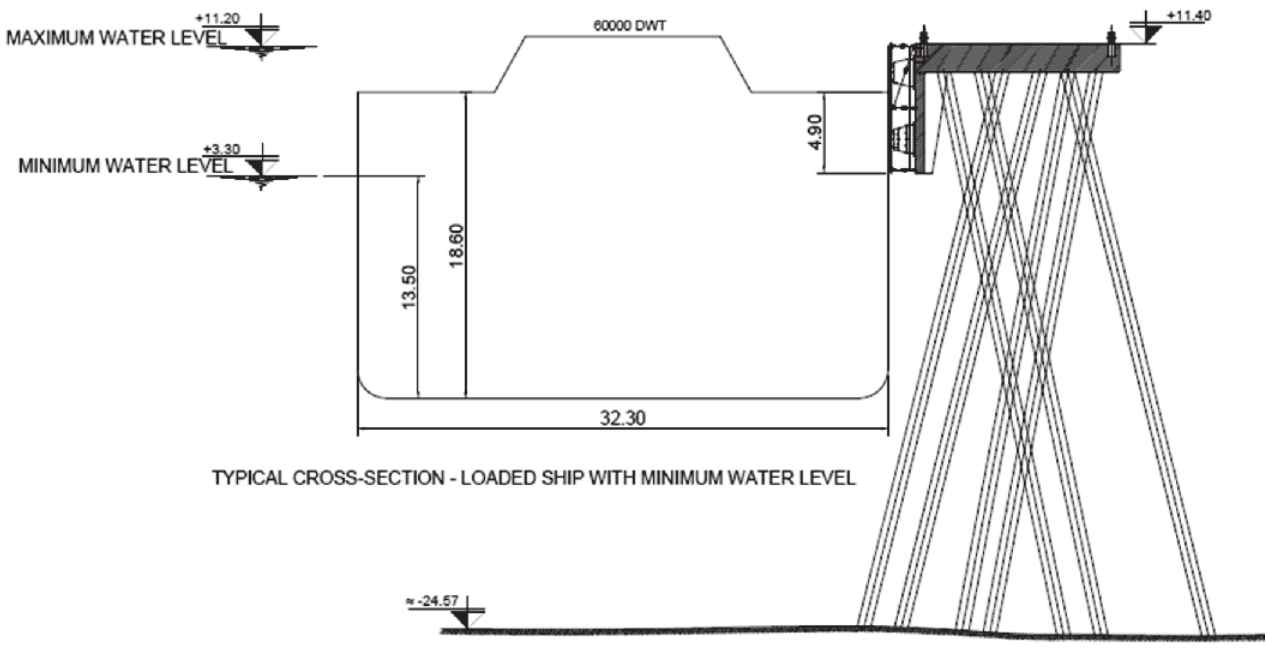
Cross section of a loaded ship with a minimum water